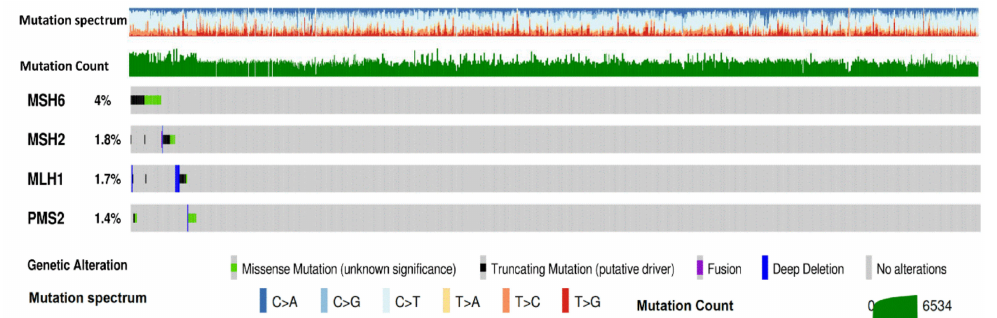
Figure 1. Oncoprint visualization of missense and truncating mutations, fusions, and deep deletions of the four main mismatch repair (MMR) genes in gastroesophageal adenocarcinomas. In this analysis involving 8 di ff erent datasets available at cbioportal.org (patients n = 973; samples n = 973), MSH6 was the most frequently altered gene with more than a two-fold frequency compared to the other MMR genes (i.e., MSH1 , MLH1 , and PMS2 ). Taken together, 75 (7.7%) samples were found to be altered in the queried genes. These tumors showed a higher mutation count. Each column represents a patient / sample and was sorted for the magnitude of alteration types in the queried genes. The types of alterations and mutation spectrum are color-coded as shown in the legend; the green bar plot refers to the mutation count, whose minimum and maximum values are reported in the green scale.